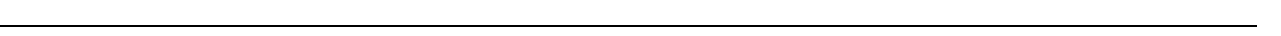
Fig. 6 Requirement of the E3 component for the in vitro ubiquitylation of a Rad50 substrate from Sulfolobus solfataricus and investigation of the key residues predicted by the structural models to be required for the functional enzymatic cascade. a The C. subterraneum srfp (E3-like) protein is required for the in vitro ubiquitylation of a S. solfataricus Rad50 substrate. (left) Lanes 1 and 2: ubiquitylation reaction containing Rad50 substrate and the ubiquitin, E1-like, E2-like proteins in the absence or presence of the srfp (E3-like) protein, respectively. ubiquitylation assay and srfp (E3-like) proteins required for the ubiquitylation cascade. (right) exclusion of any individual component from the reaction prevents ubiquitylation of the Rad50 component. The reaction in lanes 4 lacks the srfp (E3-like) component, while the reactions in lane 5 and 6 lack the E2-like and E3-like enzymes, respectively. b MS/MS spectra of the ubiquitylated S. solfataricus Rad50 peptides identi fi ed in the modi fi ed bands. (2+) indicates doubly charged precursor ions. Spectra show the annotated peaks that are due to C-terminal y (coloured red) and N-terminal b (coloured blue) fragment ions. In each case, the m/z values of the precursor ions and the m/z values of the fragment ions are consistent with ubiquitylations. The lysine modi fi ed with the ‘ TVGG ’ isopeptide-linked moiety, generated following trypsin digestion, is underlined. c Examining the importance of predicted key residues in the ubiquitin, E1-like and E2-like proteins using the functional in vitro ubiquitylation assay of the S. solfataricus Rad50 substrate. All reactions included the ubiquitin, E1-like, E2-like and srfp (E3)-like components. Mutant proteins were substituted for the native (wild-type) proteins as indicated. Lane 1, native protein (wild-type) proteins only (control); lane 2, E2-PY67/68AA (loop 4) mutant; lane 3, E2-PS103/104AA (loop7) mutant; lane 4, combination of E2-PS103/104AA (loop7) and E3-W58A mutants; lane 5, E2-PS103/ 104AQ mutant; lane 6, E3-W58A mutant; lane 7, E3-I30Q mutant; lane 8, E3-R69A mutant; lane 9, ubiquitin-T46D mutant. All assays were performed at 60 °C for 60 min as described in the methods section. Products were separated by SDS-PAGE and visualised by Coomassie